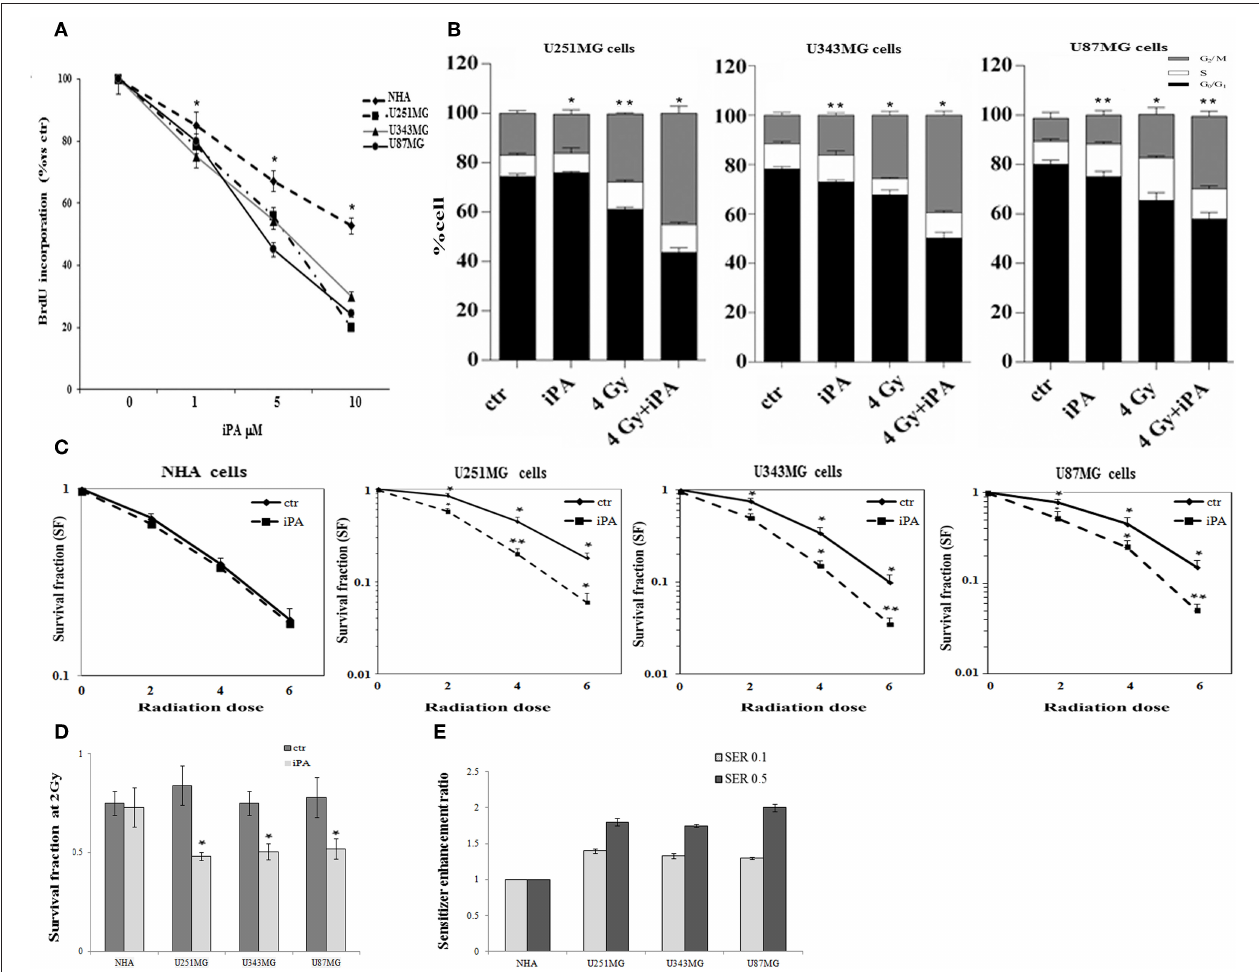
FIGURE 1 | Effect of iPA on glioblastoma cell proliferation. (A) Glioblastoma cells were cultured for 48h in the presence of the indicated concentrations (0–10 µ M) of iPA, before the assessment of BrdU incorporation. Results are expressed as means ± SD of five independent experiments performed in triplicate and reported as percentage vs. the untreated control (ANOVA, * p < 0.05 vs. control). (B) Distribution of U251MG, U343MG, and U87MG cells in the different phases of the cell cycle in cells pretreated with iPA for 48h followed from irradiation at 4-Gy as compared to IR alone. Histograms show the percentage of cells in each phase of the cell cycle. Data analyzed for statistical significant using the 2-tailed Student t-test or ANOVA following by Bonferroni correction for multiple comparisons. Results are representative of three experiments performed in duplicate, and expressed as mean ± SD (ANOVA * p < 0.05). Effect of iPA on glioblastoma cells radiosensitivity: (C) Clonogenic survival curves for NHA, U251MG, U343MG, and U87MG cells were exposed to 1 µ M of iPA or DMSO for 48h and irradiated with increasing doses of X-rays, followed by an additional 24h post-irradiation incubation in iPA containing medium. The results shown represent the average of 3 independent experiments. (D) The survival fraction at 2-Gy (SF2) of human glioblastoma cells lines treated with iPA or control (DMSO) for 48h pre-irradiation. Values are the mean survival fraction ± SD of at least 3 independent experiments. Error bars represent the standard error. *indicates p < 0.05. (E) Sensitizer enhancement ratios (SER)